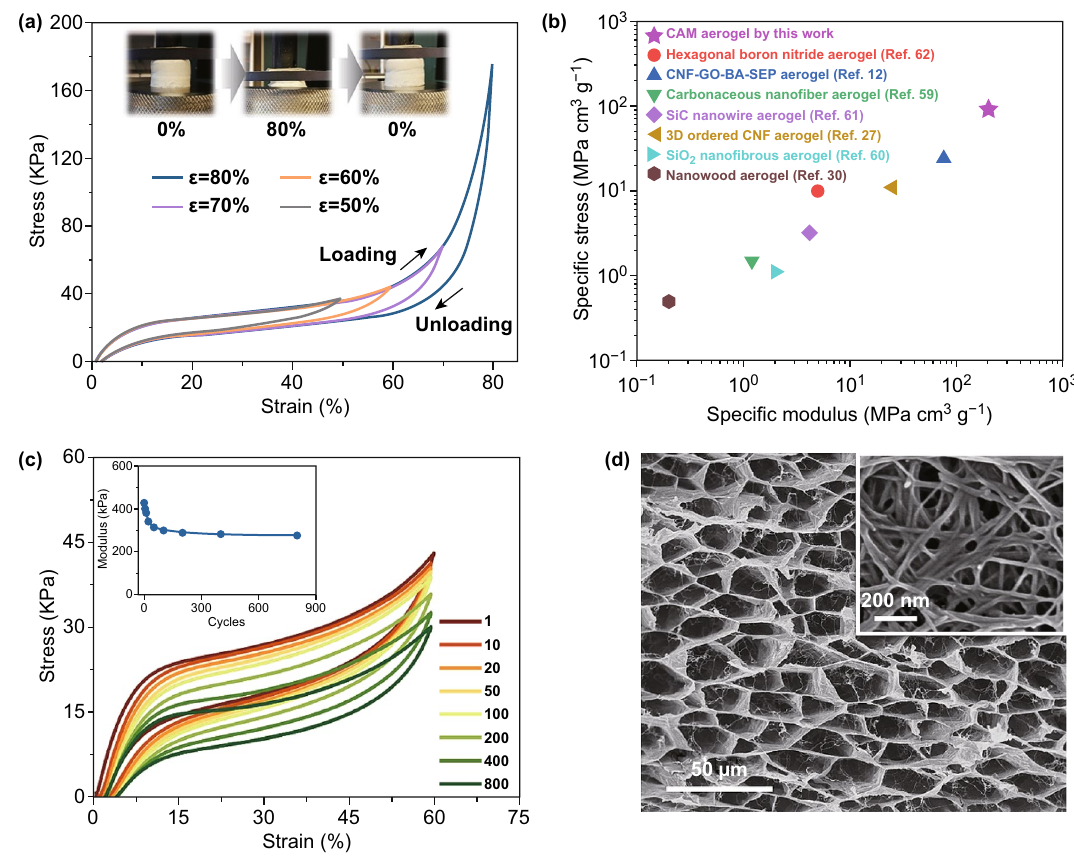
Fig. 4 Mechanical properties of the CNF@Al‑MIL‑53 (CAM) aerogel. a Reversible compressive stress–strain curves of the CAM aerogel ( ρ = 2 mg cm −3 ) using different levels of strain; the insets are photographs of a compression–decompression test cycle. b Comparison of the CAM aerogel with other aerogels in terms of specific stress ( σ / ρ ) and specific modulus ( E/ρ ). c The results of an 800‑cycle fatigue test on the CAM aerogel ( ρ = 2 mg cm −3 ) at a compressive strain of 60%. d Scanning electron microscopy images of the CAM aerogel after the